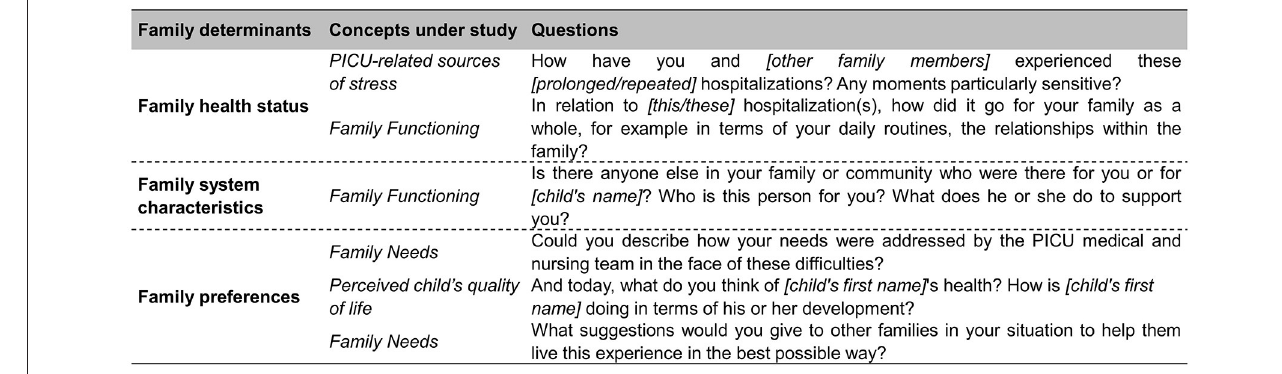
of coding rules. In the next step, an immersive reading and individually according to the language used in the